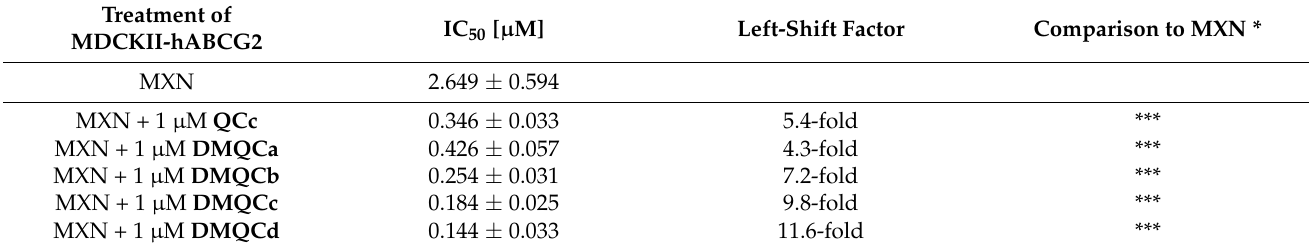
Table 2. Left-shift factor calculated as IC 50 MXN/IC 50 MXN in combination with quinazoline derivatives determined in MDCKII-hABCG2 cells using WST-1 assay. IC 50 values are given as mean ± SEM, N = 3, two-way ANOVA, * represents significant difference in comparison to single MXN treatment, (*** p <